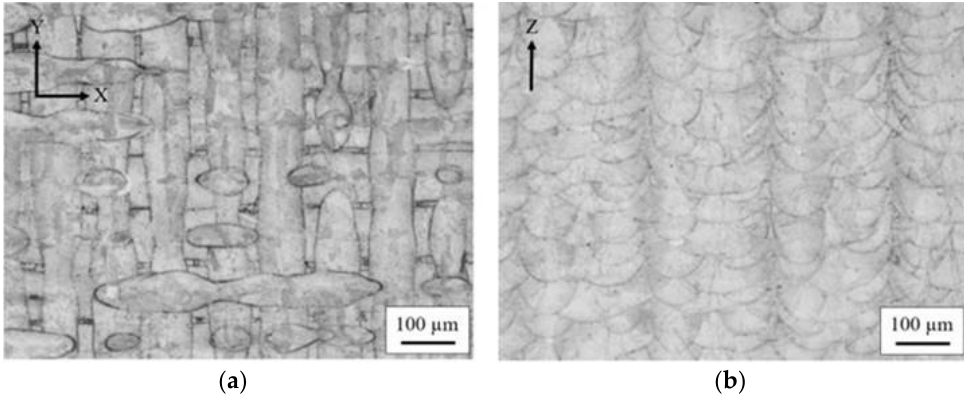
Figure 1. OM of AB specimen in the ( a ) XY build plane, and ( b ) Z build direction.